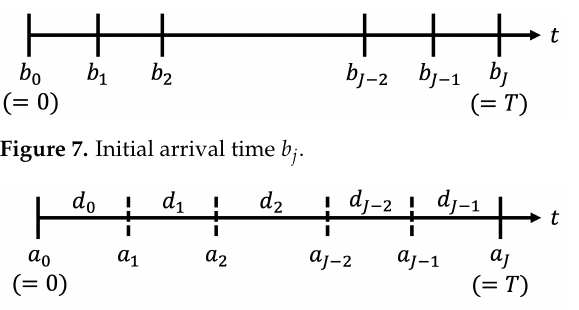
Figure 8. Adjusted inter-arrival time d j with adjusted arrival time a j